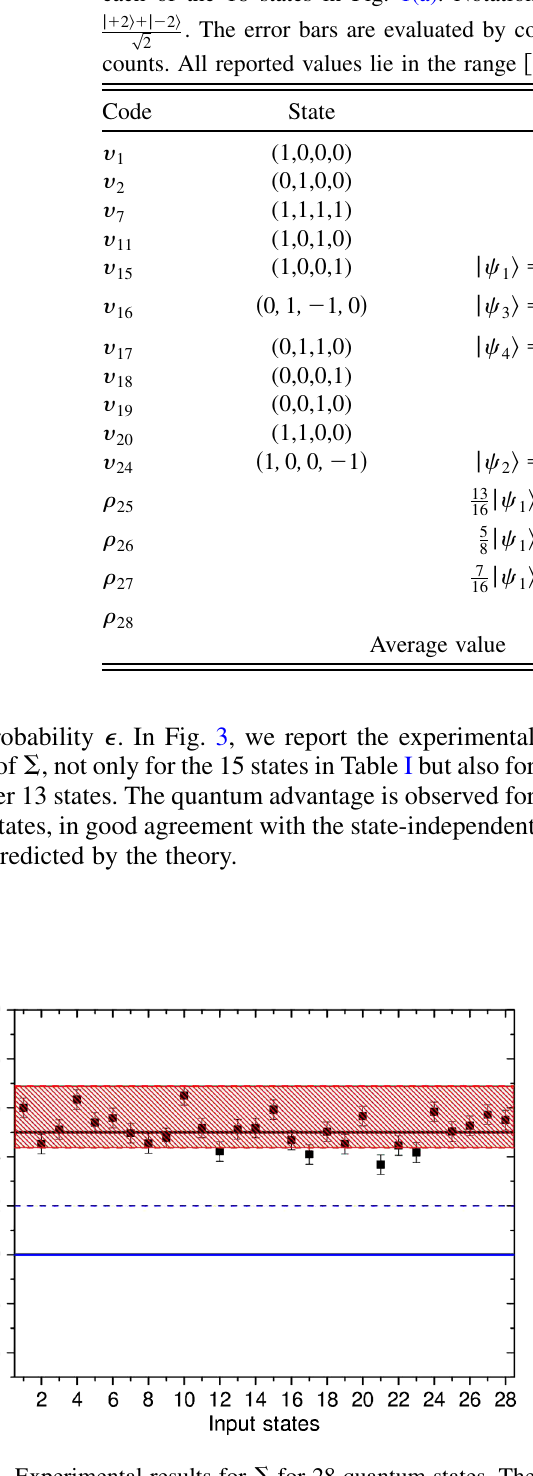
p and j h i ¼ 2